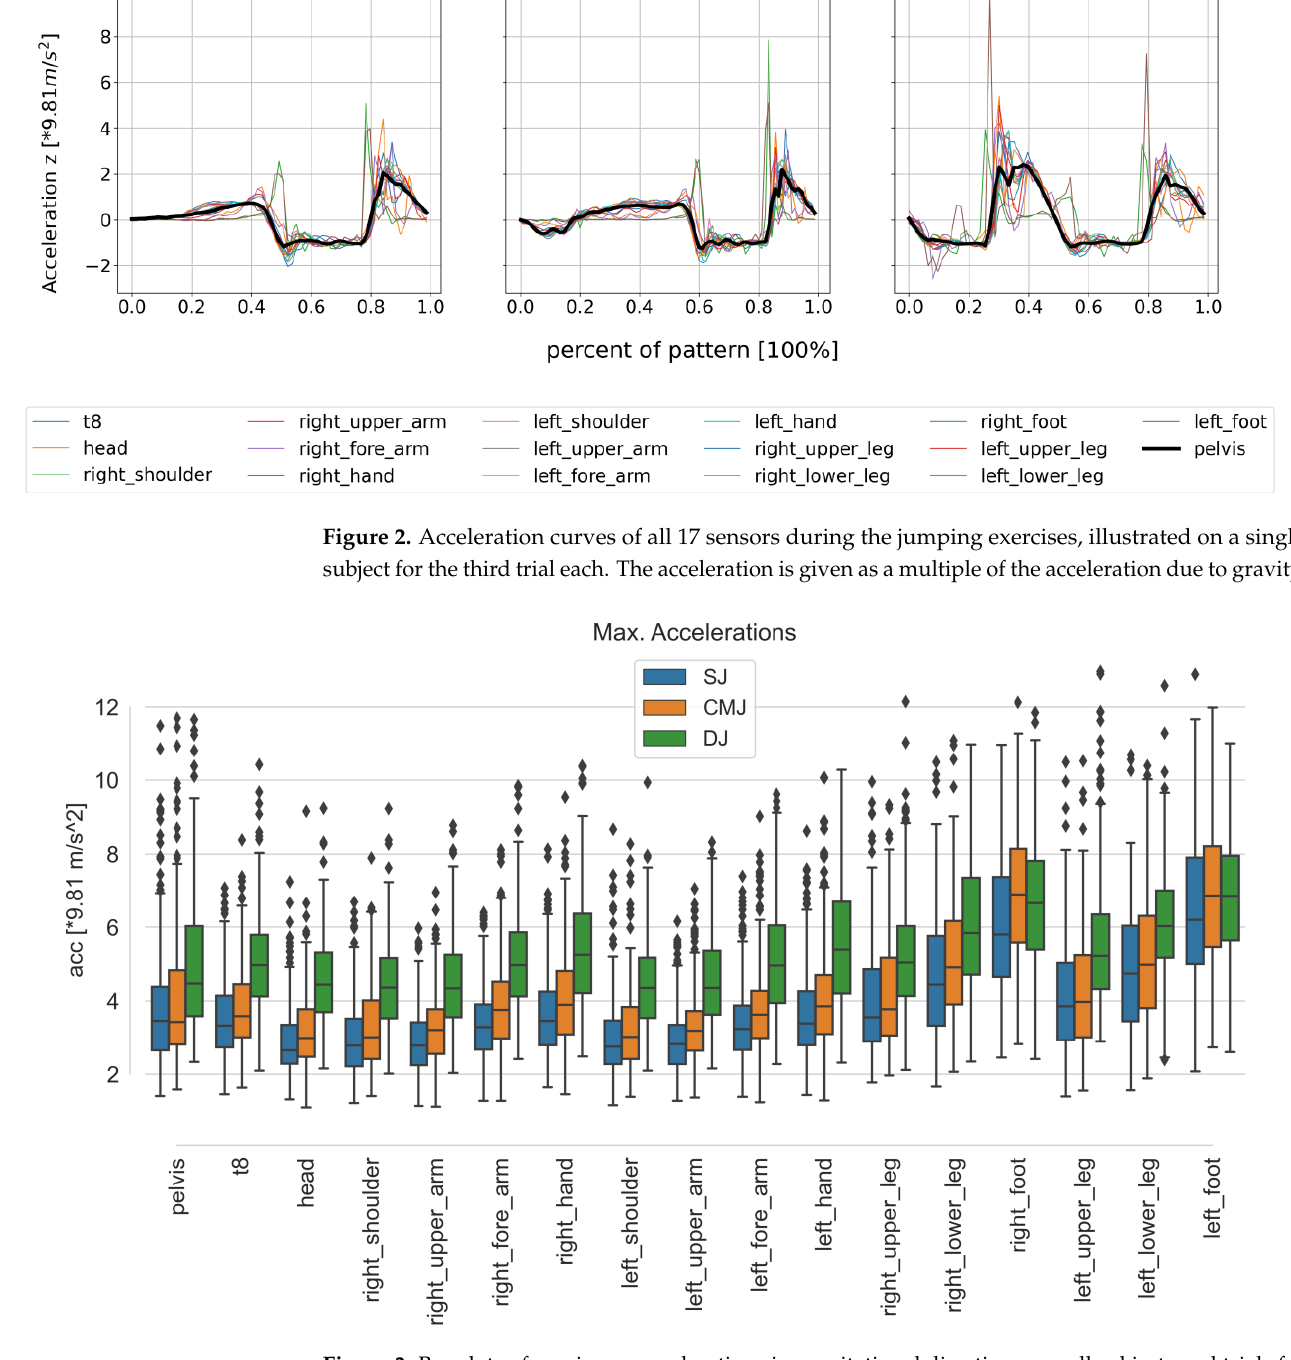
Figure 3. Boxplots of maximum accelerations in gravitational direction over all subjects and trials for each sensor and exercise.